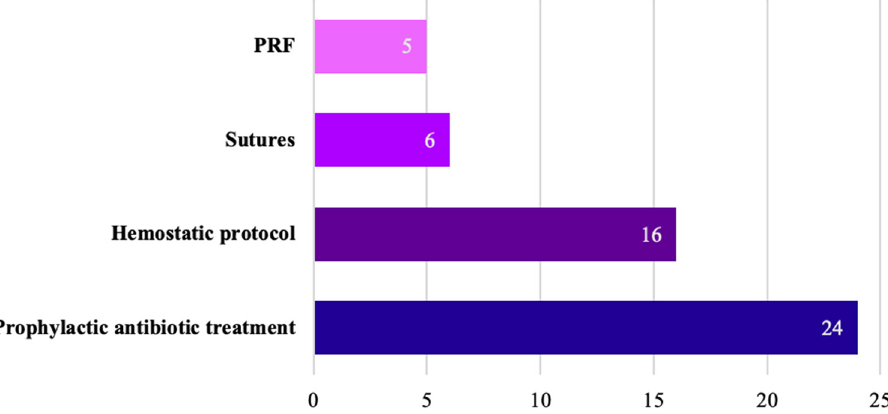
Fig. 3. Question 6: Protocol modi fi